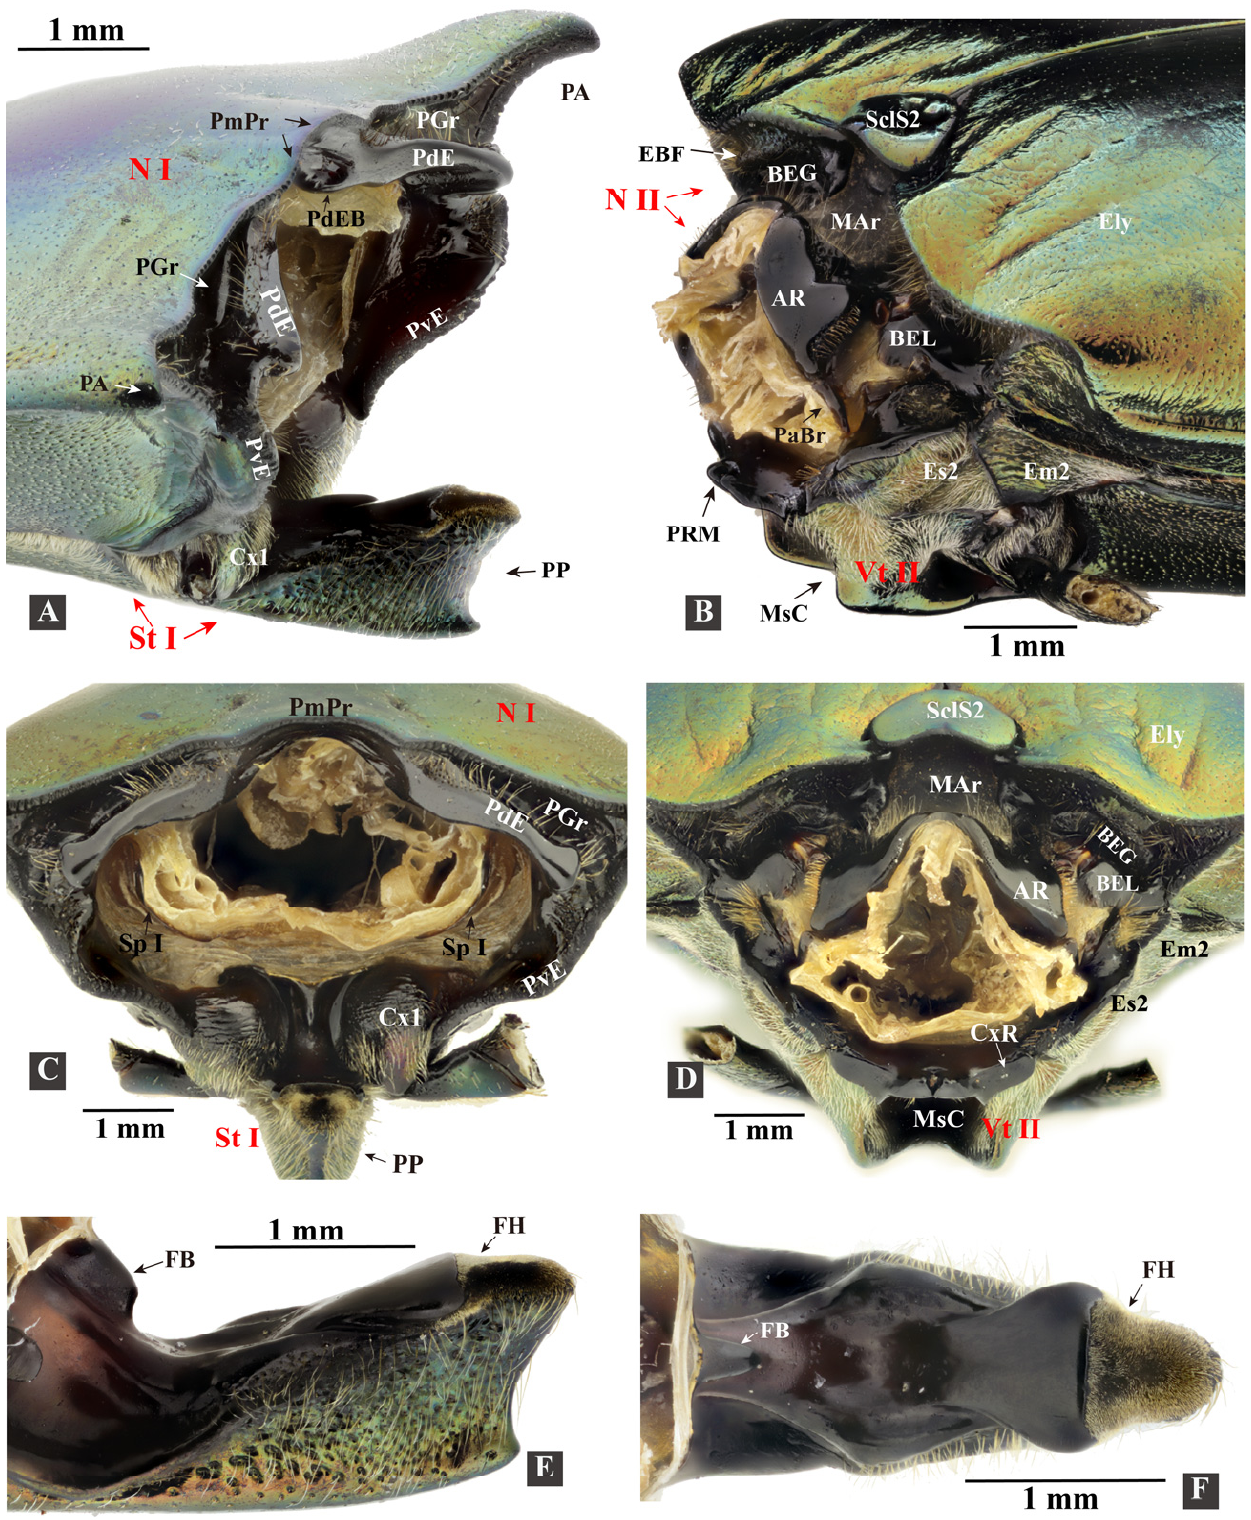
Figure 2. Exoskeleton of Campsosternus auratus . See Section 2 ‘Materials and Methods’ for abbrevi- ations. ( A ) posterolateral view of the posterior part of the prothorax. ( B ) anterolateral view of the mesothorax. ( C ) caudal view of the prothorax. ( D ) frontal view of the mesothorax. ( E ) lateral view of the prosternal process. ( F ) dorsal view of the prosternal